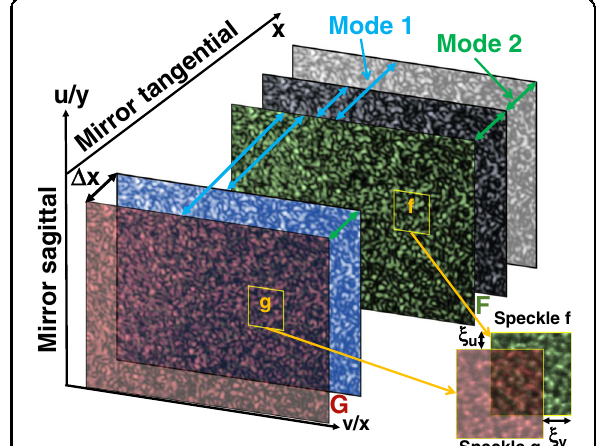
Fig. 2 Illustration of 2 data processing modes and coordinate axes and main de fi nitions. F and G are, respectively, the speckle image at the reference position and at the measured position on the SUT. f and g are corresponding subsets of F and G . u and v are, respectively, the horizontal and vertical coordinates of the camera. x and y are, respectively, the tangential and sagittal coordinates of the mirror ’ s SUT. Δ x is the scanning step